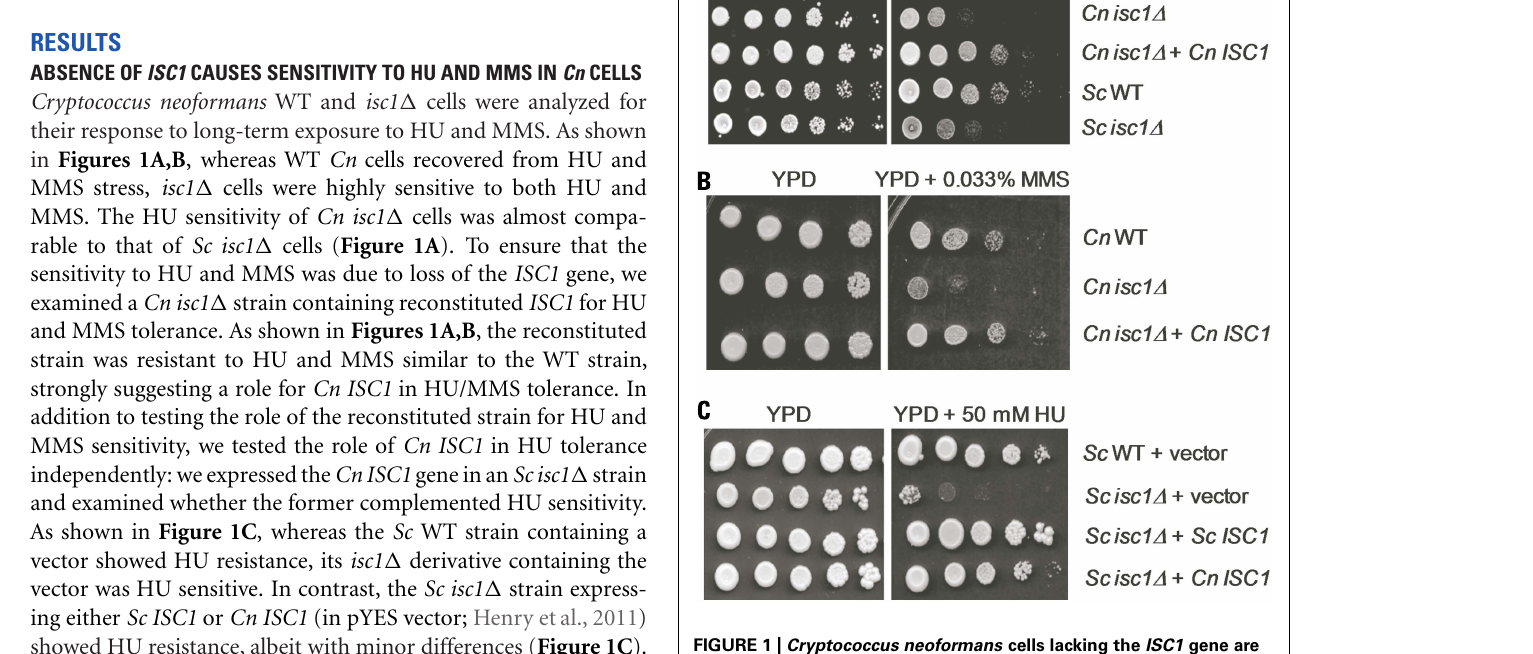
FIGURE 1 | Cryptococcus neoformans cells lacking the ISC1 gene are sensitive to HU and MMS. (A) Ten-fold serial dilutions of log-phase cultures of C. neoformans (WT, isc1 (cid:2) , and isc1 (cid:2) + Cn ISC1 reconstituted) and S. cerevisiae (WT and isc1 (cid:2) strains) were spotted on plates containing YPD andYPD + HU (50 mM). (B) Ten-fold serial dilutions of log-phase cultures of C. neoformans (WT, isc1 (cid:2) , and isc1 (cid:2) + Cn ISC1 reconstituted) were spotted onYPD andYPD + 0.033% MMS plates. (C) Cn ISC1 complements HU sensitivity of the S. cerevisiae isc1 (cid:2) strain.Ten-fold serial dilutions of following log-phase cultures were spotted on SD/Ura − and SD/Ura − /HU plates: Sc WT cells containing pYES vector, Sc isc1 (cid:2)